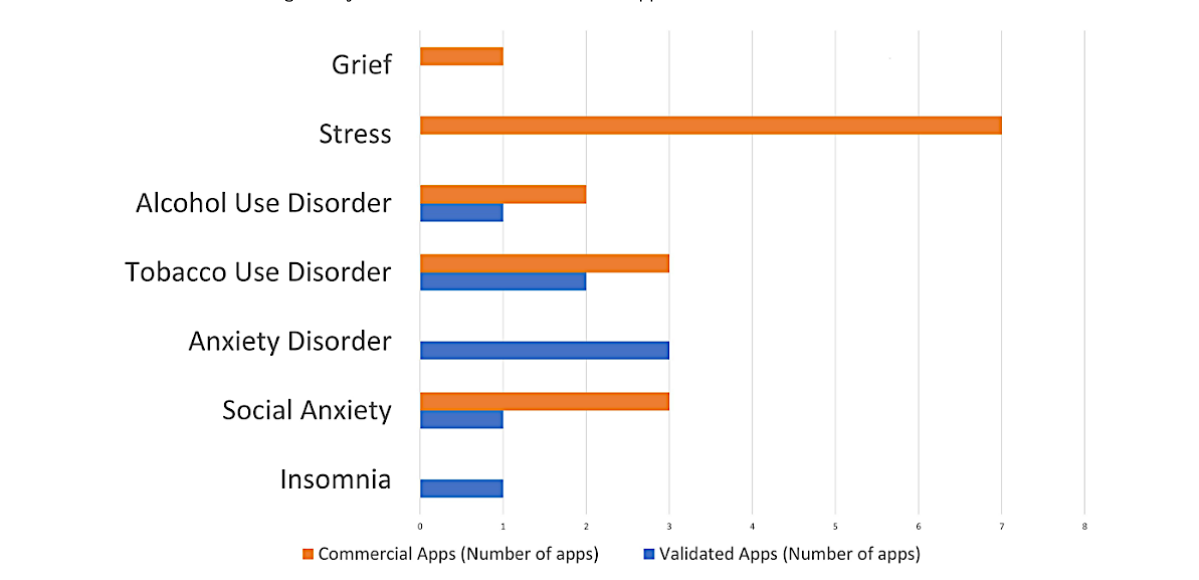
Figure 3. Overview of conditions targeted by both commercial and validated